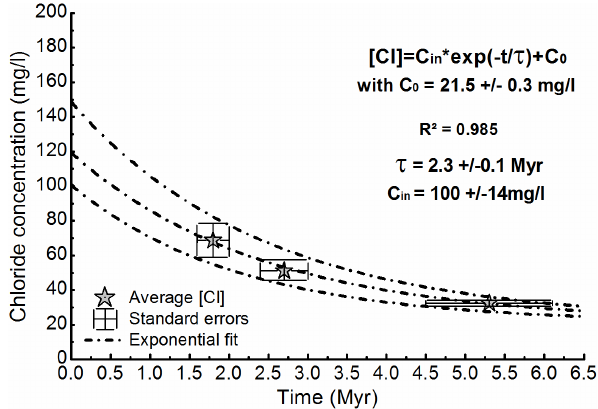
Figure 7. Average chloride concentration for each transgression zone versus the elapsed time since the transgression.